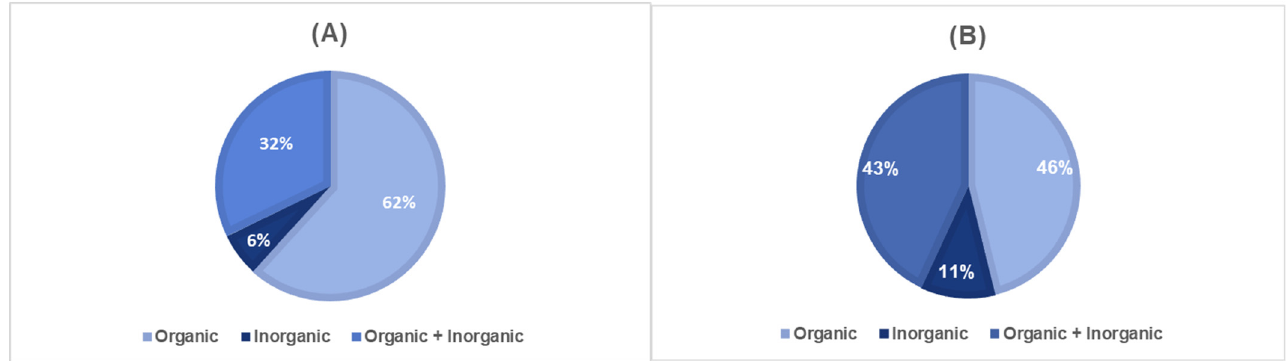
Figure 3. Usage frequency of sunscreens containing only organic, only inorganic, or a combination of organic and inorganic UV filters in ( A ) adults’ and in ( B ) children’s sunscreens.